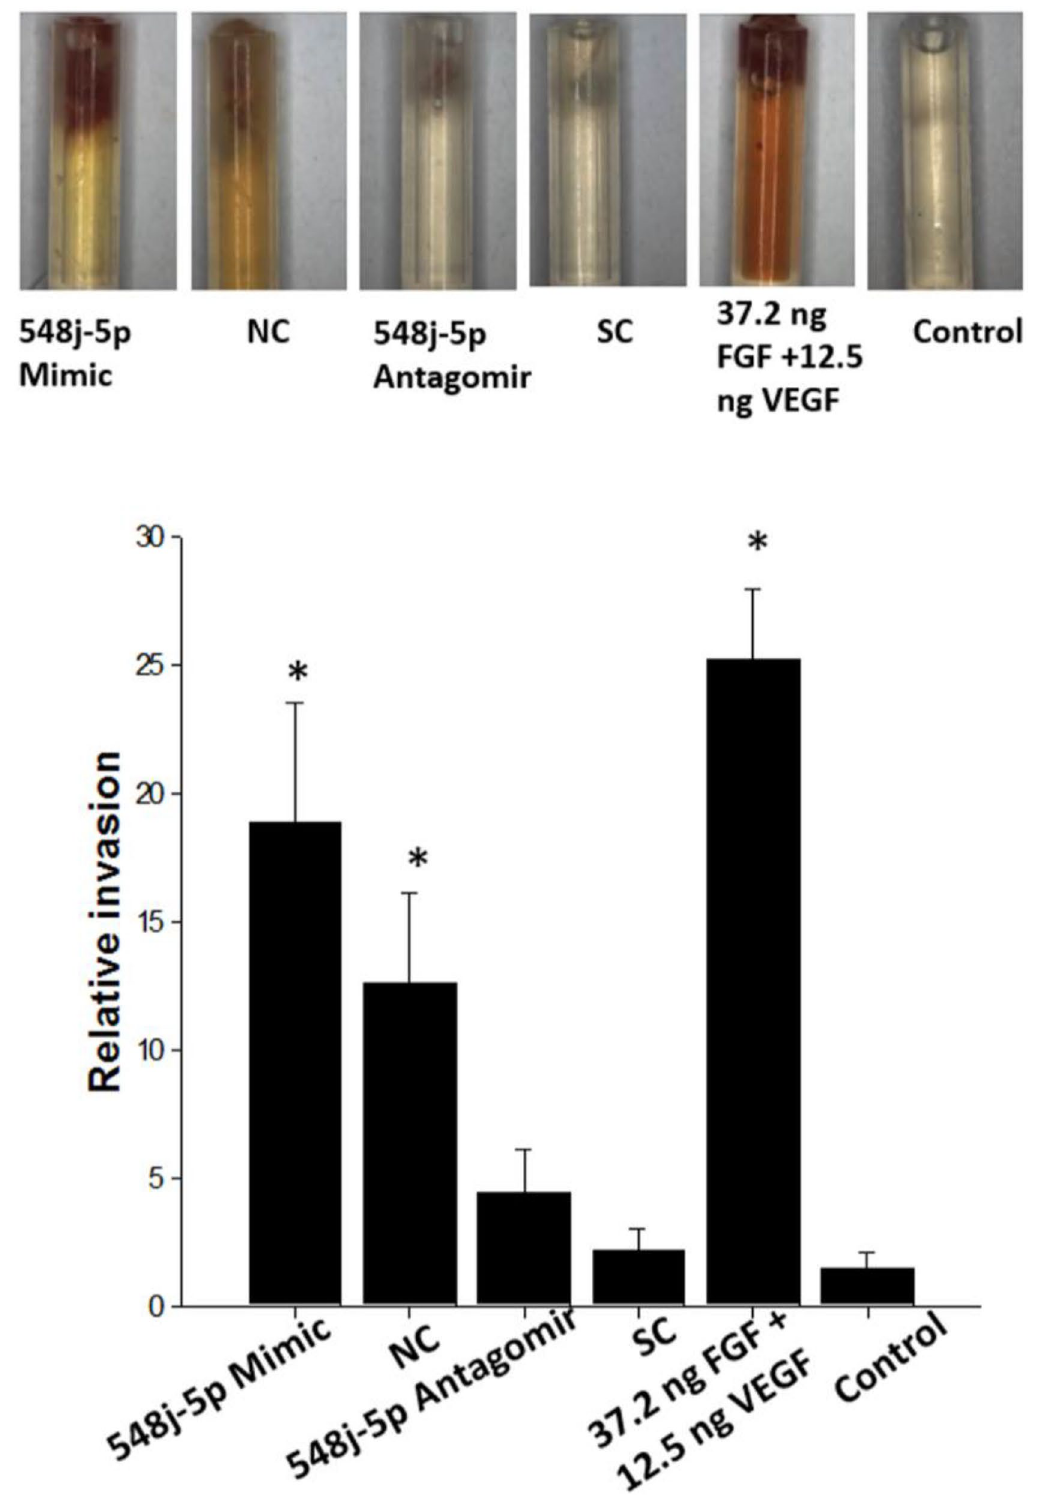
Figure 4. Effect of miR-548j-5p on blood vessel formation in vivo, assessed using a directed in vivo angiogenesis assay. Representative images of angioreactors removed from nude mice 9 days after implantation showed that miR-548j-5p enhanced blood vessel formation. While FGF-2 and VEGF have both been demonstrated to promote angiogenesis in DIVAA, the FGF/VEGF mixture provides a synergistic effect, allowing a drastic increase in response using a lower growth factor concentration. 548j-5p Mimic: transfected with miR- 548j-5p mimic; NC: transfected with miR-mimic negative control; 548j-5p Antagomir: transfected with miR- 548j-5p antagomir; SC: transfected with miR-scramble control. Data are presented as the mean ± SEM (* P < 0.05 vs. control, n = 6 for each